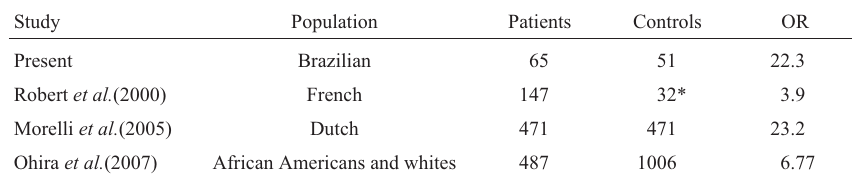
Table 2 - Different risks of DVT in the combined presence of AB alleles and FVL allele